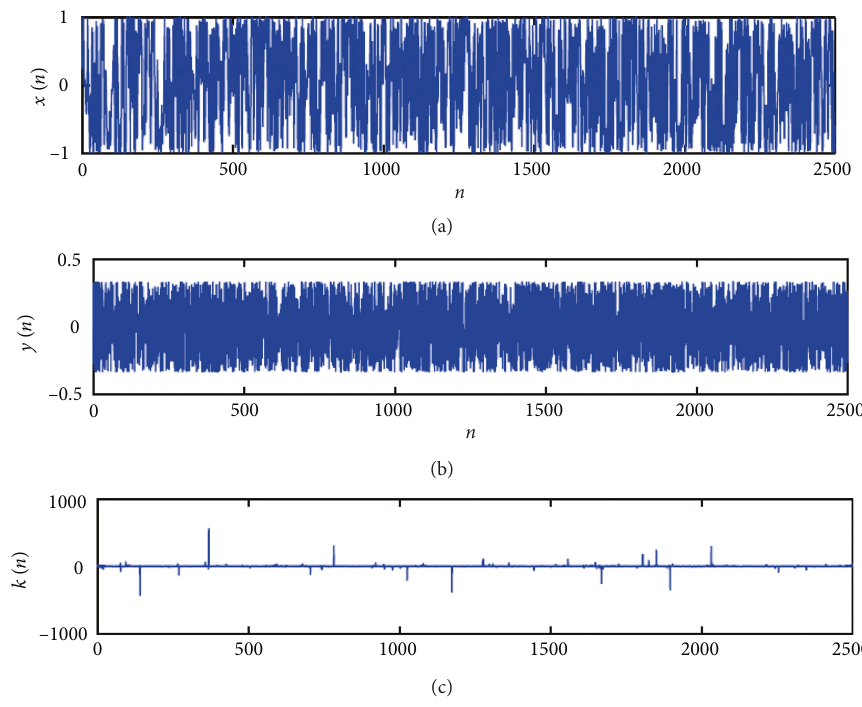
Figure 1: Time responses of TD-ERCS for initial parameters ( x